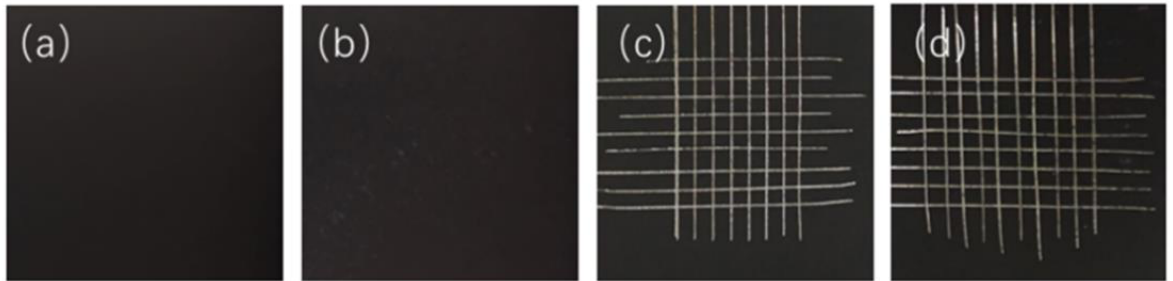
Figure 9. Typical adhesion test image of thermal cycling test of PB 0.96 samples. ( a , c ) Morphology and cross-cuts image before thermal cycling test. ( b , d ) Morphology and cross-cuts image after thermal cycling test.